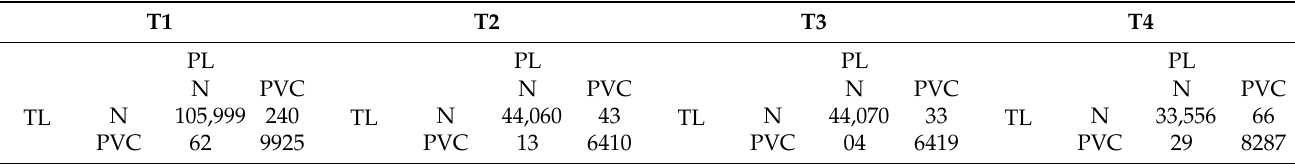
Table 1. Confusion matrixes for all the experiments using the proposed method.